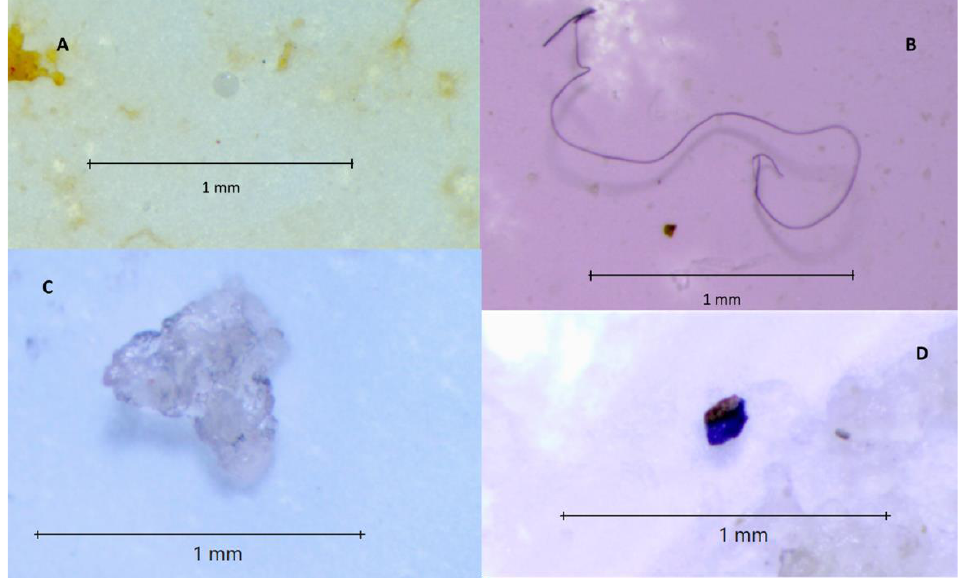
Figure 2. MPs isolated from mussel samples. ( A ) spherical granule; ( B ) fibre; ( C ) film; ( D ) frag- ment.